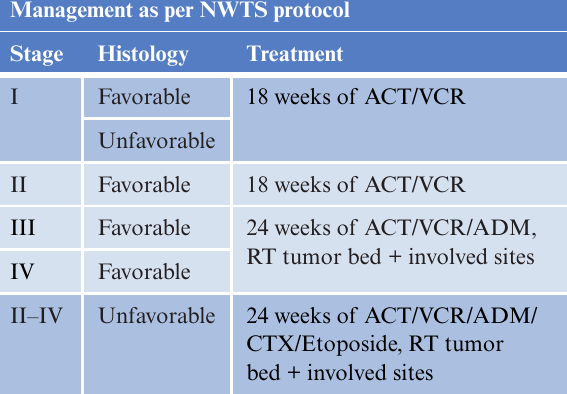
Table 2: Management as per NWTS protocol.